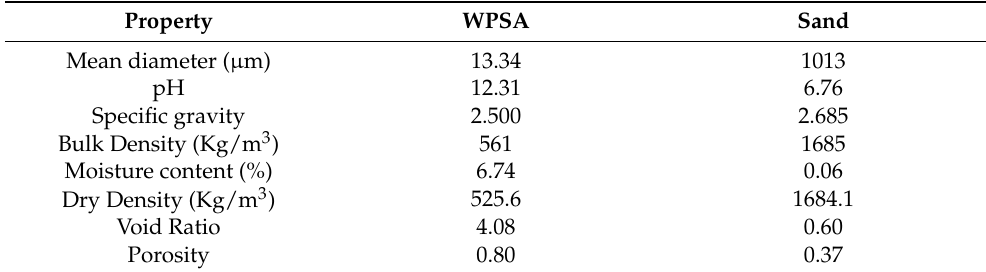
Table 1. Physical characteristics of WPSA and sand.